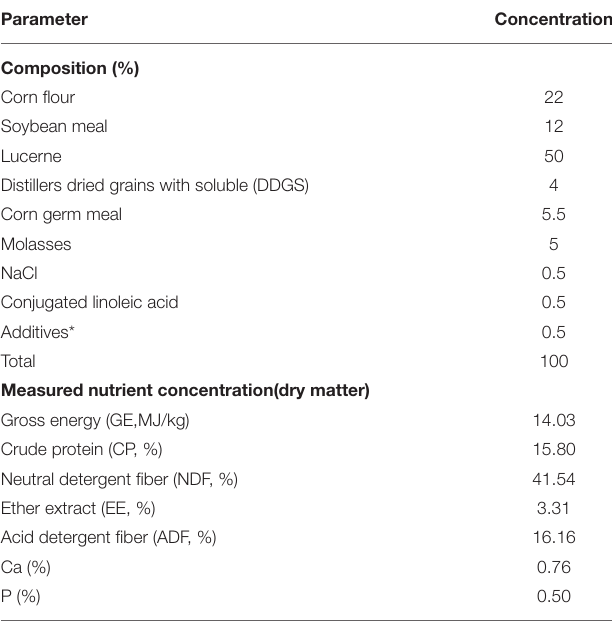
TABLE 1 | Composition and nutritive levels of control